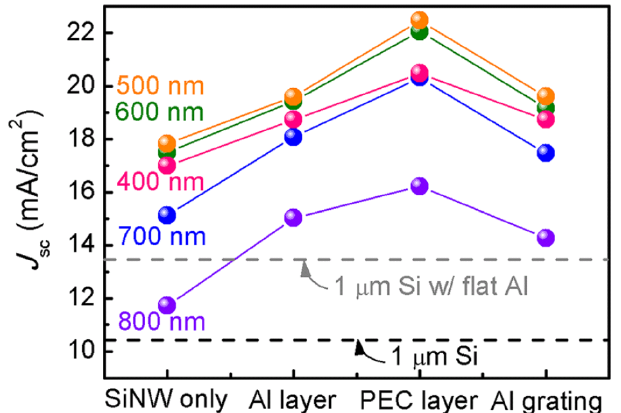
Figure 6. ( a ) Ultimate efficiency as a function of embedded depth into silver back reflectors (Ag BRs). ( b ) Optical losses by Ag BRs. Reprinted with permission from [55]. Copyright © 2012 Optical Society of America.